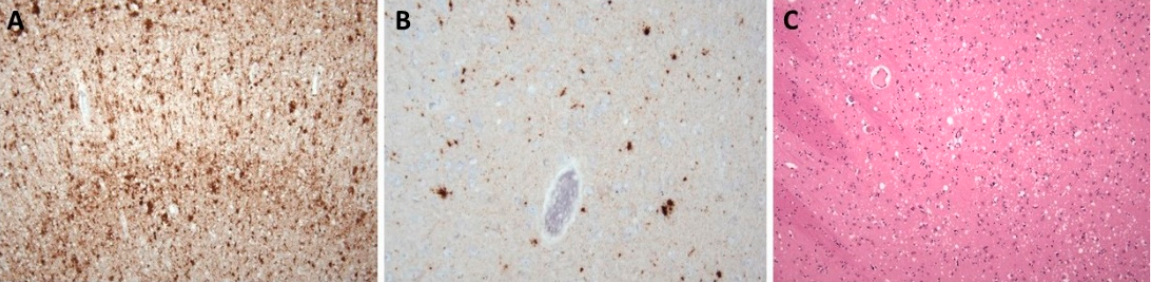
Figure 6. Neuropathological finding showing changes corresponding to Creutzfeldt–Jakob disease. ( A ) Diffuse synaptic positivity, enhanced perivacuolar “patchy” positivity and “plaque-like” positive structures in cerebral cortex, stained with monoclonal antibody (12F10) against prion protein, original magnification 200×; ( B , C ) diffuse synaptic positivity and enhanced perivacuolar “patchy” positivity and “plaque-like” positive structures in striatum, stained with monoclonal antibody (6H4) against prion protein, original magnification 200× and H&E staining, original magnification 100×. The most common form is sporadic Creutzfeldt–Jakob disease (sCJD). It manifests with heterogenous symptoms with a dominating rapidly progressive cognitive